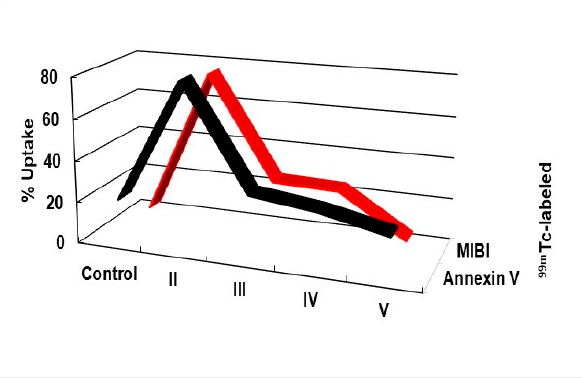
Figure 4. Correlation of 99 mTc-HYNIC-annexin V or 99 mTc-MIBI with MCF-7 cells underwent asiaticoside treatment for 48 h. Percentages of uptake are plotted with a best-fit line by linear regression analysis and are shown as (r 2 = 0.97).